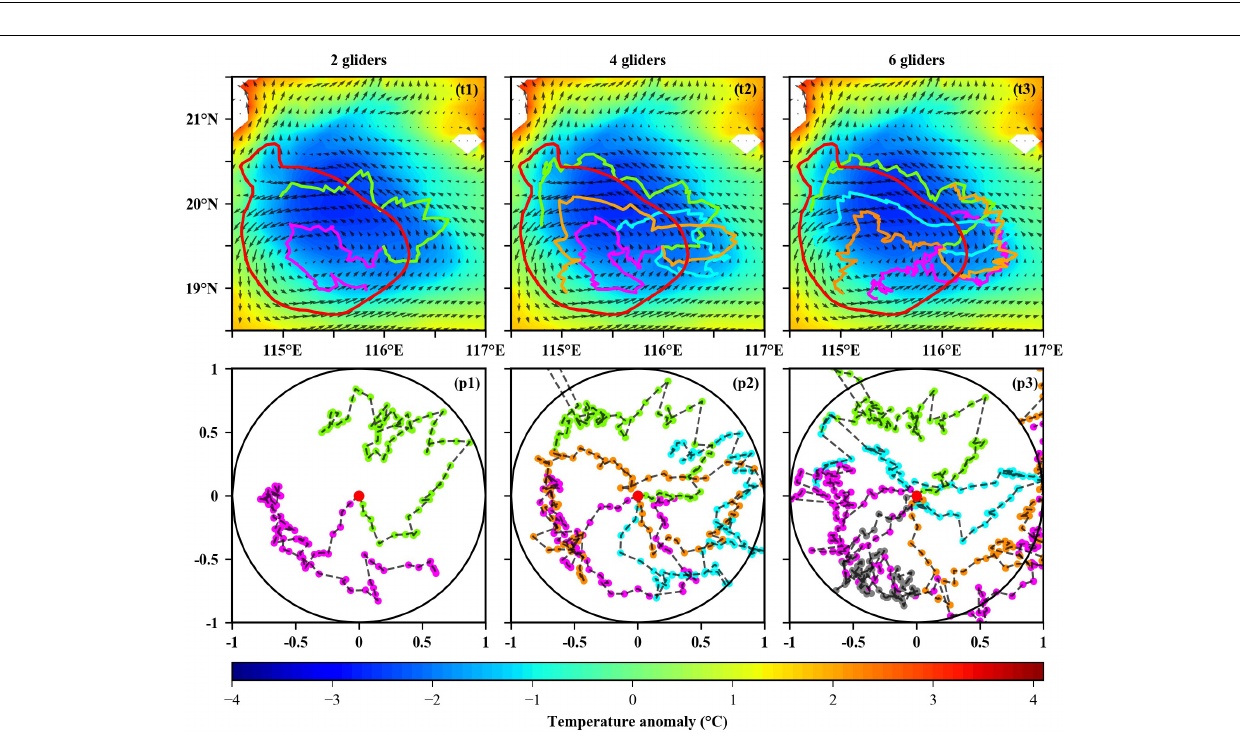
FIGURE 8 | The results of 2, 4, and 6 gliders used to track the target eddy on July 24, 2015. The first column is the trajectory of gliders, the second column is the normalized position of gliders.